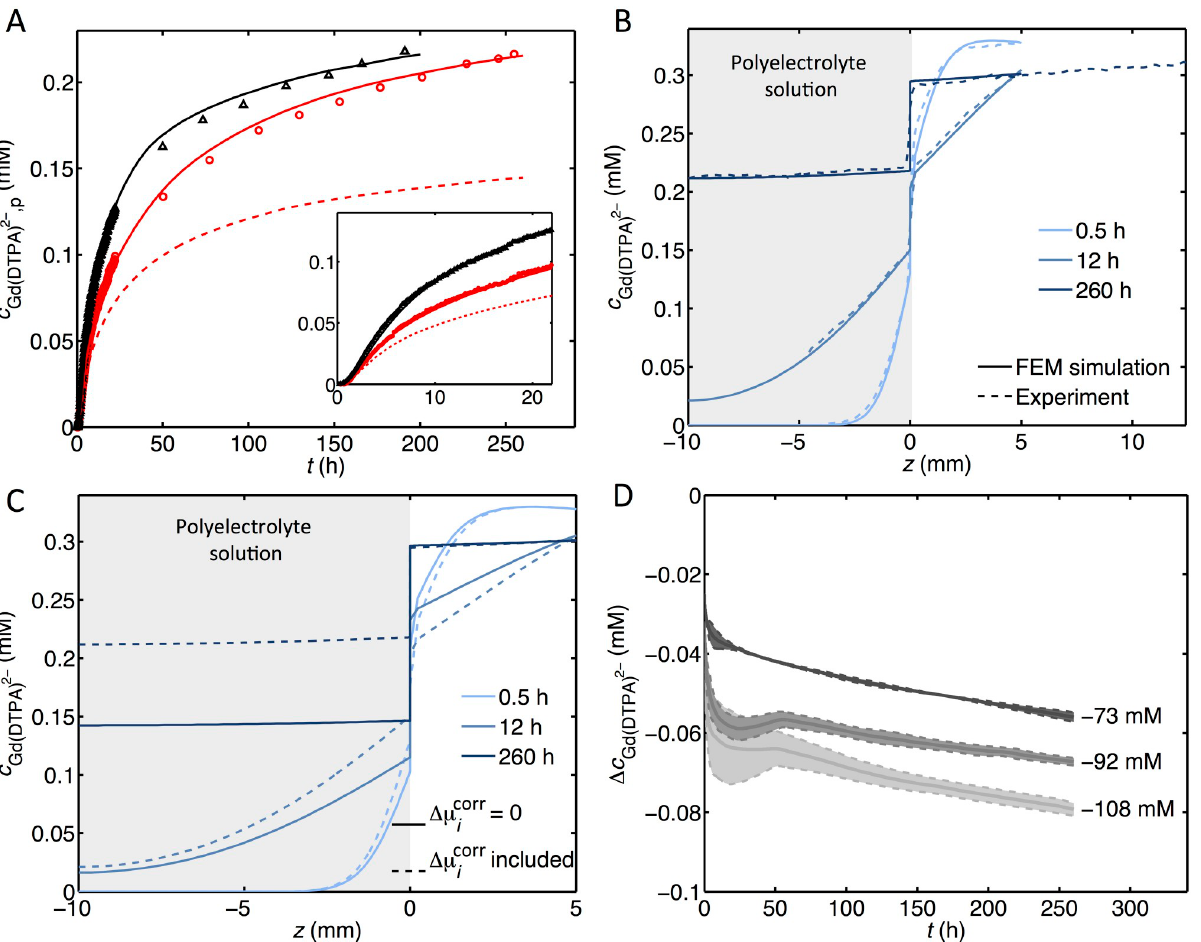
Fig 3. Compiled results from experiment and FEM simulations. (A)The concentration of Gd(DTPA) 2 − in the polyelectrolyte solution at a position 4 mm from the membrane for two samples with FCD = -108 mM: one with small effects due to convection (circles) and one with noticeable convection at the beginning of the experiment (triangles), as a function of time. The solid lines are the corresponding values from FEM simulations with fitted values of D m corr and the dashed line represents the corresponding results from a simulation with D m corr ¼ 0 for all ions. (B) Experimental (dashed) and i G : 2 (cid:0) simulated (solid) values for the concentration of Gd(DTPA) 2 − at different positions along the container, z , for a polyelectrolyte solution with FCD = -108 mM. (C) Simulated values for the concentration of Gd(DTPA) 2 − at different positions along the container, z , for a polyelectrolyte solution with FCD = -108 mM. The dashed line shows the result from a FEM simulation with fitted value of D m corr and the solid line represents the corresponding G : 2 (cid:0) results from a simulation with D m corr ¼ 0 for all ions. (D) The step in concentration at z = 0, D c ¼ C G : 2 (cid:0) (cid:0) C G : 2 (cid:0) (see also Fig 4), at different times G : 2 (cid:0) p ð 0 (cid:0) Þ i s ð 0 þ Þ for three polyelectrolyte solutions with different FCD. The dashed lines correspond to the individual experiments and the solid lines represent the corresponding mean value of the duplicate experiments. The data are taken from FEM simulations.